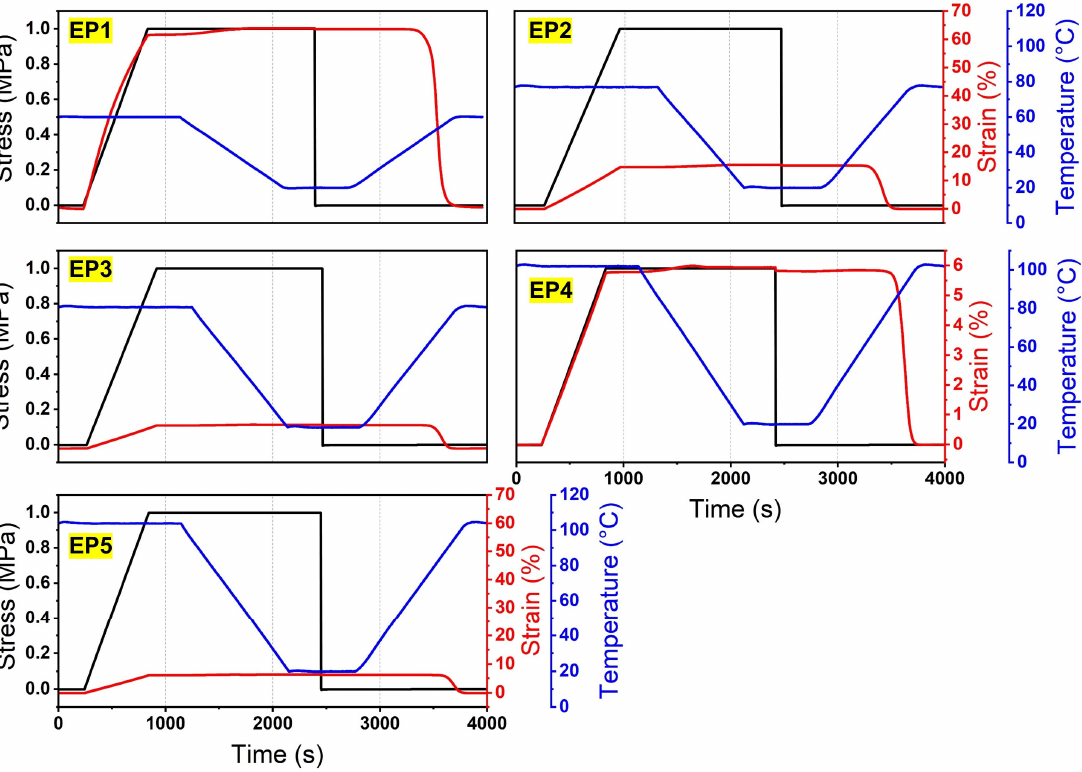
Figure 4. Shape memory cycle curves of different constituted SMEPs obtained by single cantilever DMA method (EP1, EP2, EP3, EP4, EP5, respectively correspond to mole ratio of epoxy monomer to curing agent 𝜂 = 1.00, 1.25, 1.50, 1.75, 2.00).